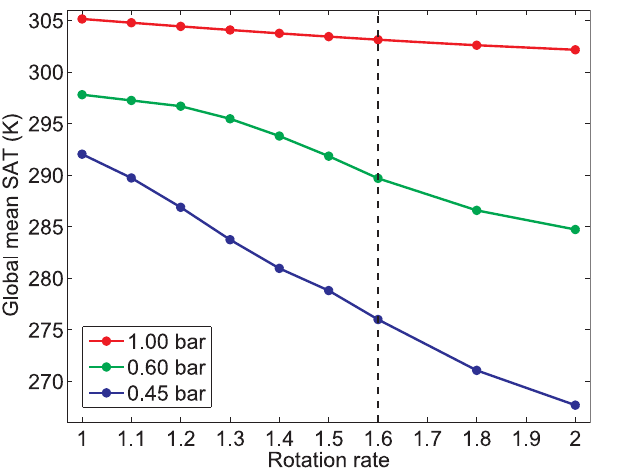
Fig. 20. Dependency of the global mean SAT on the Earth’s rota- tion rate for three CO 2 partial pressures of 0.45bar (blue), 0.60bar (green) and 1.0bar (red). The early Archean rotation rate of (cid:127) =1.6 is marked with the black dashed line.